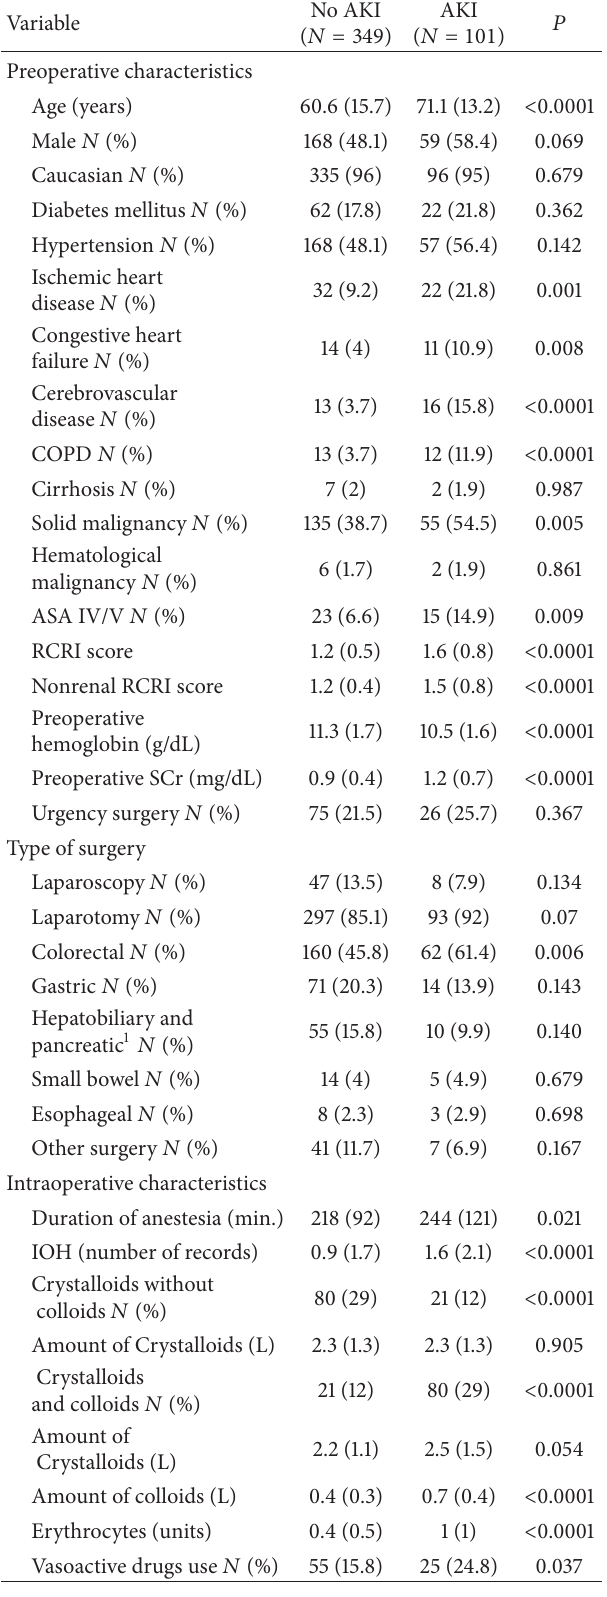
Table 2: Characteristics of patients with postoperative AKI ( 𝑁 = 101 ) and with no postoperative AKI ( 𝑁 = 349 ).